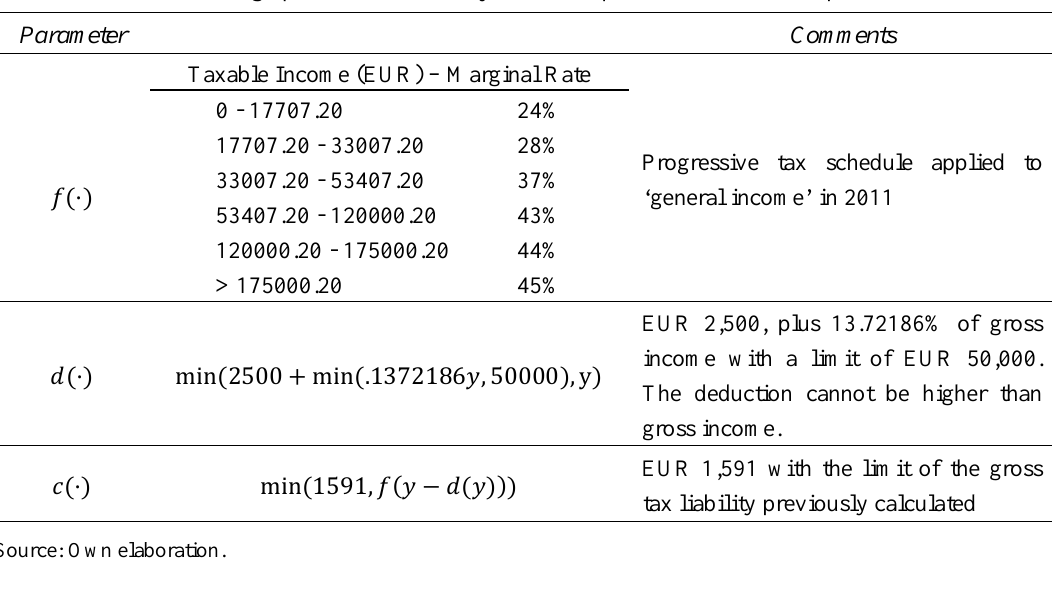
Figure 1: Progressivity and redistribution of the PIT